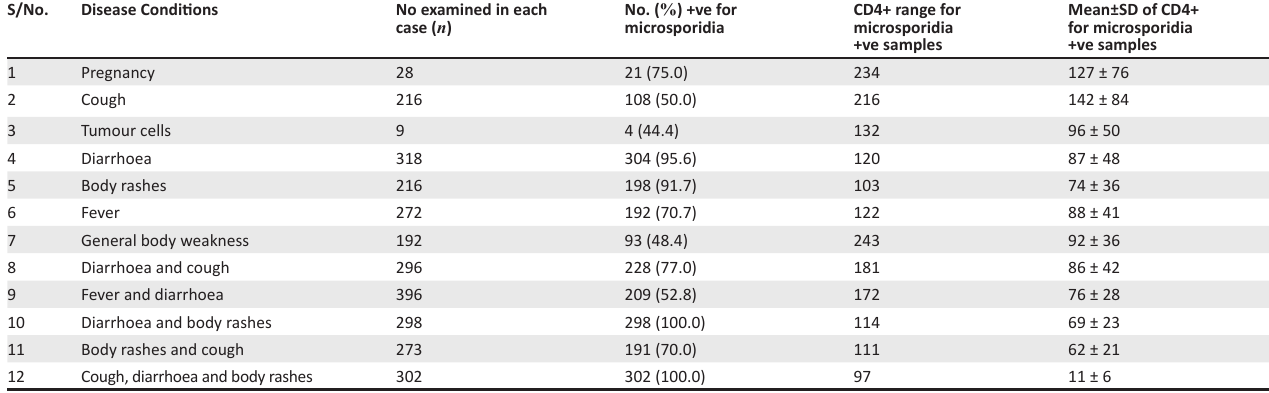
TABLE 4 : Association of Microsporidiasis with other disease conditions in HIV-positive cases. S/No. Disease Conditions